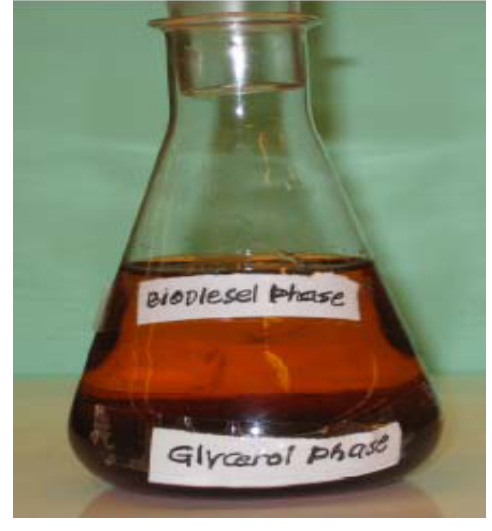
Figure 7. Biodiesel using NaOH catalysts.